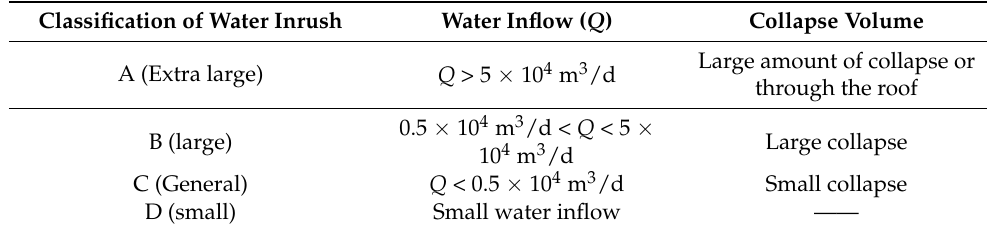
Table 5. Hazard classification.